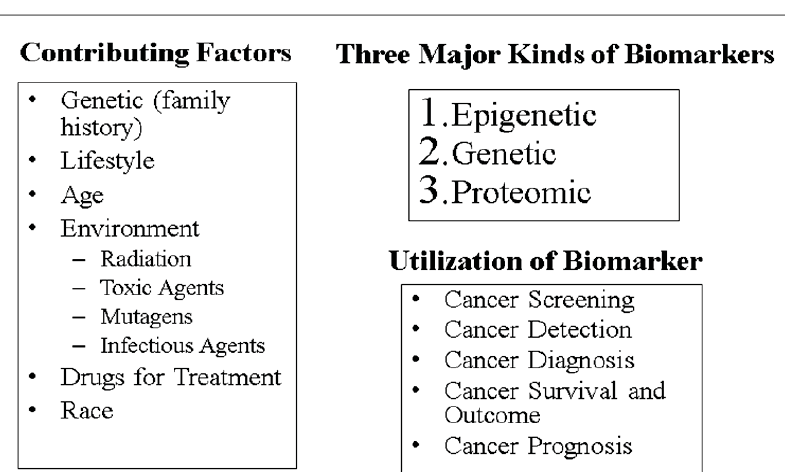
Figure 1. Major risk factors of prostate cancer and a broad classification of biomarkers of prostate